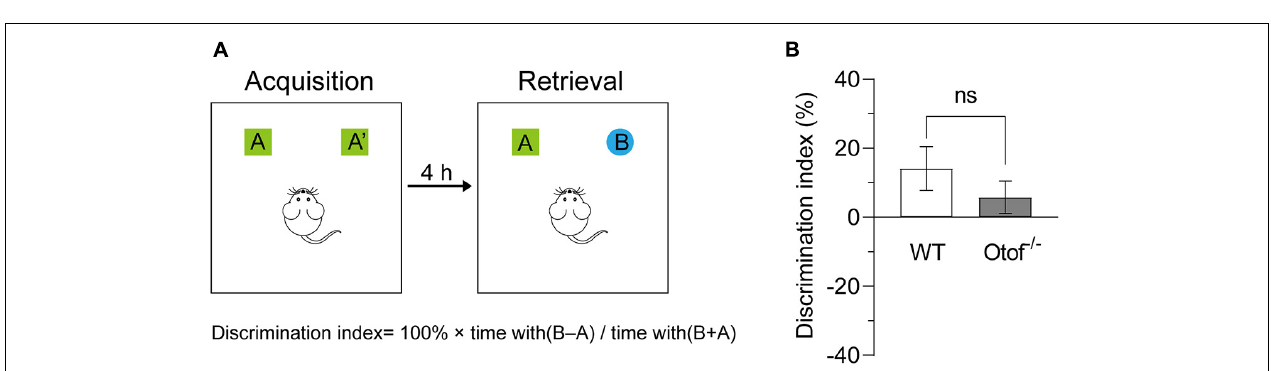
FIGURE 4 | Otof − / − mice showed unimpaired novel object recognition. (A) Experiment diagram of the novel object recognition test. (B) Compared with WT mice, Otof − / − mice showed a comparable object discrimination index (DI). All values are presented as mean ± SEM and analyzed by unpaired t -test. WT: n = 11; Otof − / − : n = 14. WT, wild-type mice; Otof − / − , otoferlin knockout mice; ns, not